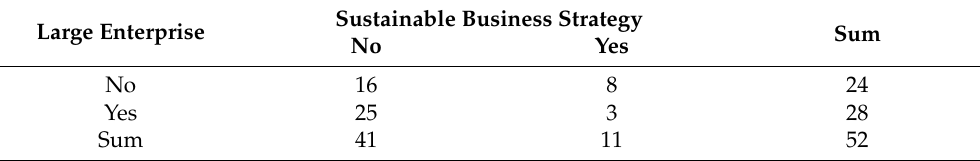
Table 14. Cross-way table for variables: Large Enterprise and Sustainable Business Strategy (0.266). Large Enterprise